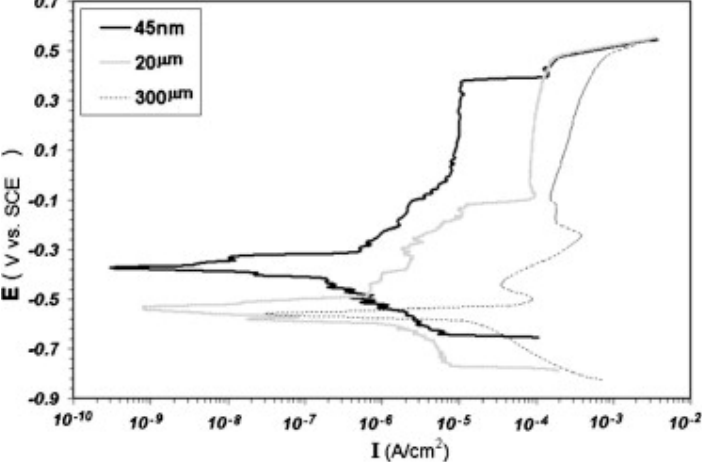
Figure 7. Effect of nanocoating and microcoating structure size. Nanograin size had the lowest i corr in 10 wt.% NaOH [53].